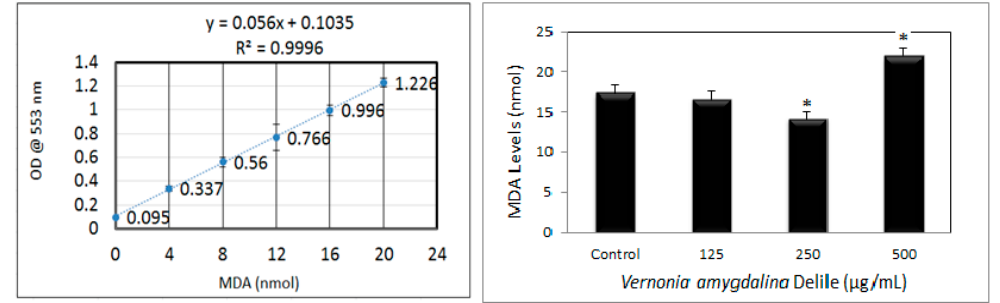
Figure 4. Malondialdehyde (MDA) standard curve ( Left ) and effects of Vernonia amygdalina Delile (VAD) extract on MDA level in PC-3 cells ( Right ). PC-3 cells were treated with various doses of VAD: 125, 250 and 500 µg/mL. MDA concentrations were determined as described in Materials and Methods section. Data are expressed as means ± SD ( n = 3). * Significantly different from the control by ANOVA and Dunnett’s test; p < 0.05.